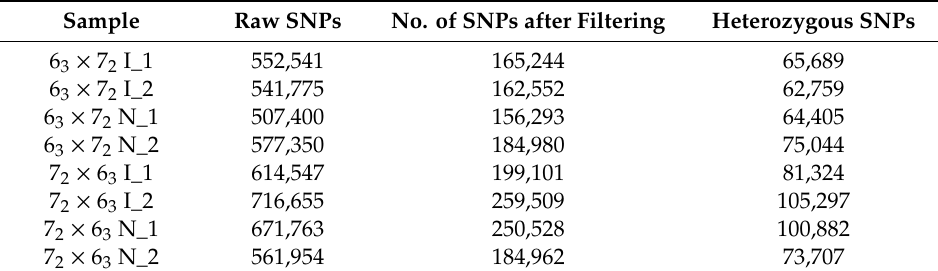
Table 2. Number of raw, screened, and heterozygous single nucleotide polymorphisms (SNPs). Sample